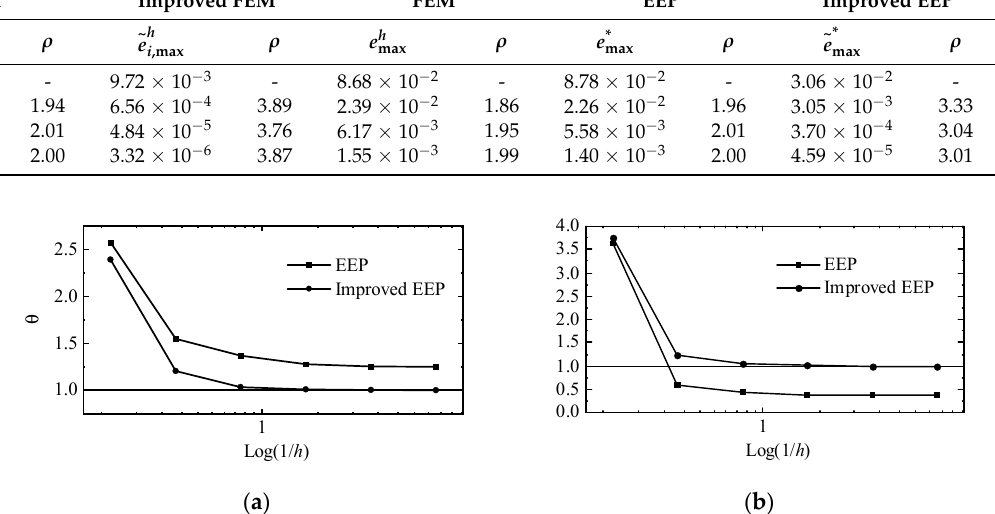
Figure 8. Distributions of effective index: ( a ) component in the x direction; ( b ) component in the y direction.